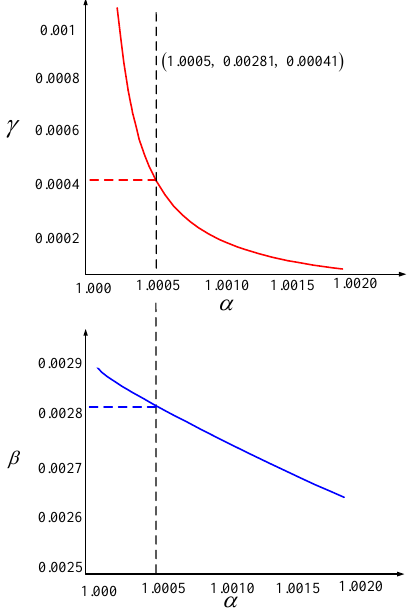
Figure 10. The corresponding 2D figures about ( α , β , γ ). Step 5: Selecting one point on the intersection curve, the corresponding value of ( α , β , γ ) can be obtained. Step 6: L F and C F can be determined by (29)–(30) or